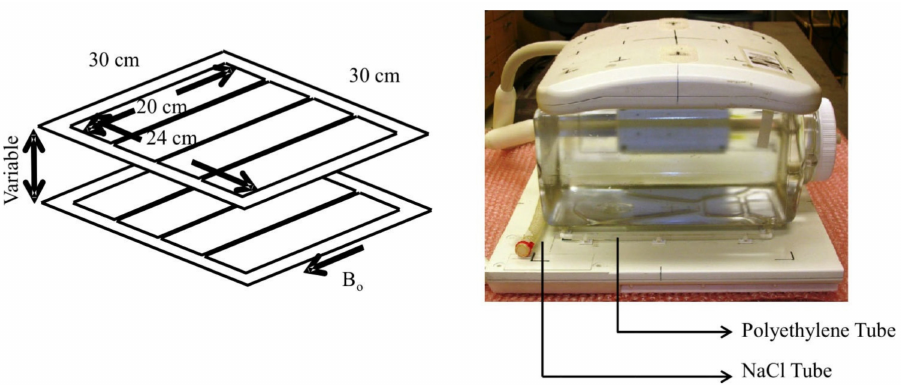
Figure 12. The eight-channel dual-tuned sodium and hydrogen torso coil with the polyethylene and NaCl tubes employed for co-registration and signal intensity reference for estimating tissue sodium concentration. Reprinted by permission from James et al., Abdom Imag 2015